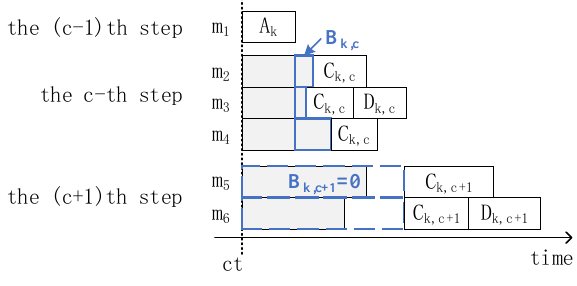
Figure 5. Example of operation execution